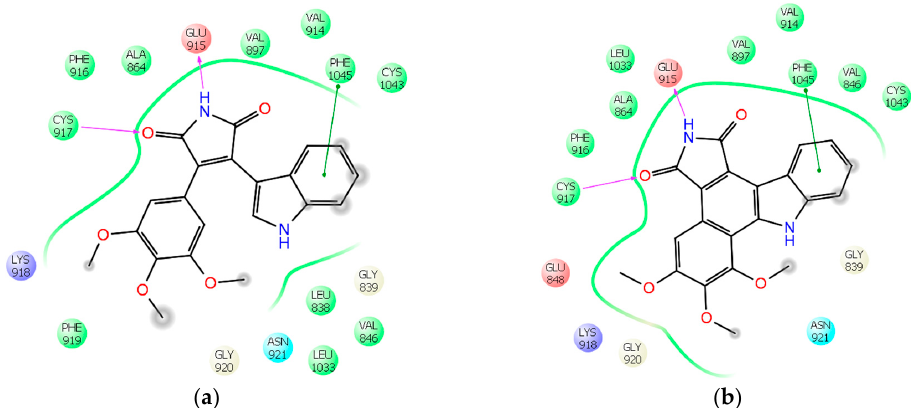
Figure 1. Modeled ligand interaction diagrams of VEGFR-2 inhibitors 1 and 3 in the ATP binding pocket of VEGFR-2 (pdb code 3CJF). Key ligand protein interactions are shown including H-bonds of the maleimide moiety towards Glu915 and Cys917 in the hinge region. ( a ) Binding mode of 1 ; ( b ) Binding mode of 3 .